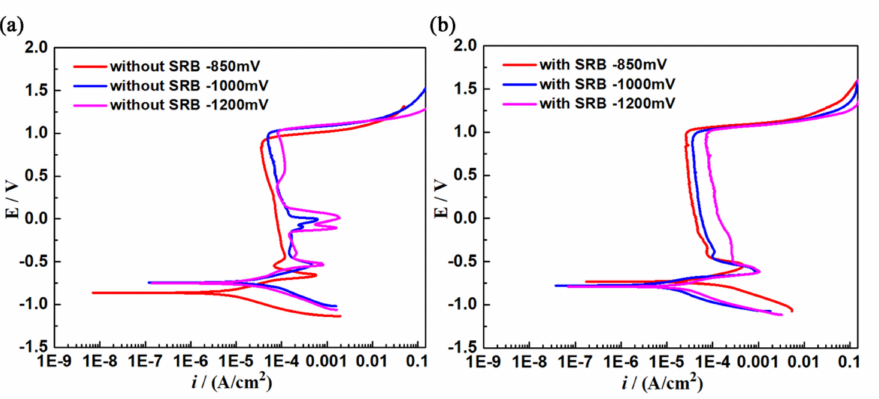
Figure 7. Polarization curves (0.5 mV/s) of different cathodic protection potentials of X80 steel in sterile and inoculated environments for 3 days: ( a ) without SRB; ( b ) with SRB. Table 1. Tafel fitting data of polarization curves of X80 steel in sterile and inoculated environments.